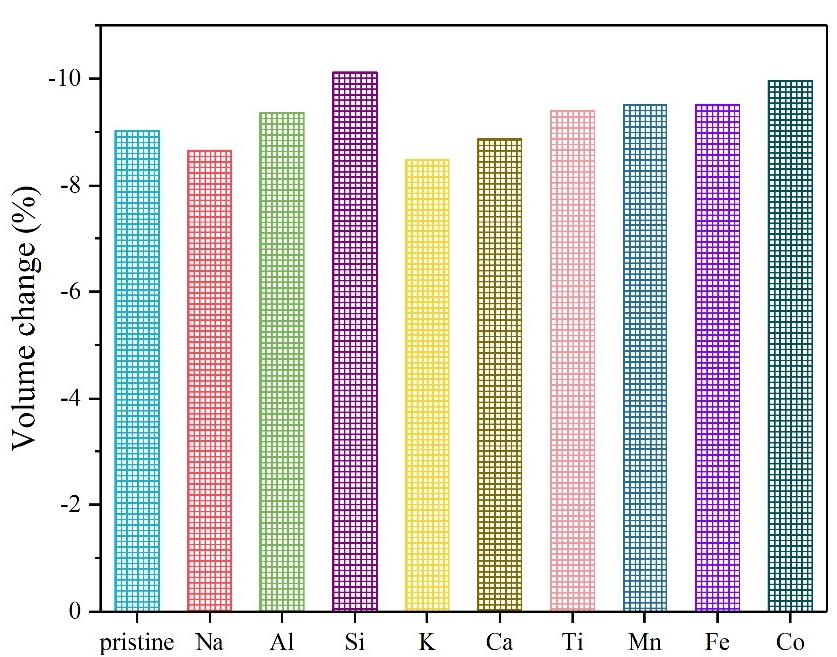
Figure 3. The volume changes of pristine and various doped Mg 2 NiH 4 electrode materials.